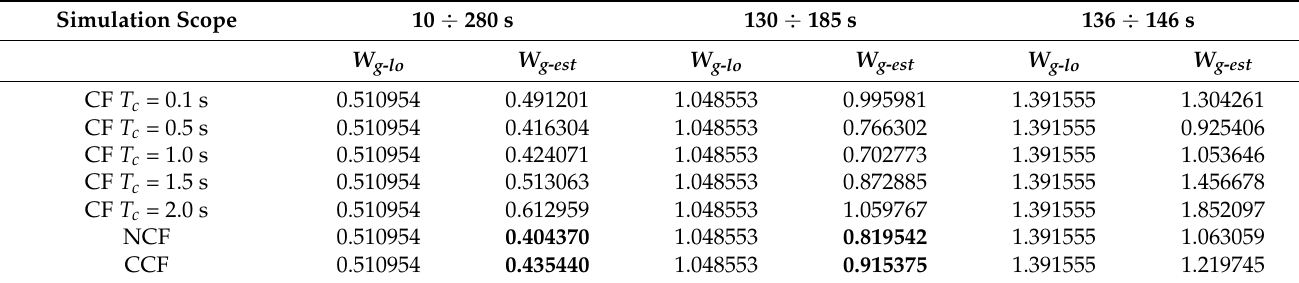
Table 3. The results of computation of performance indices for delay = 1.5 s.